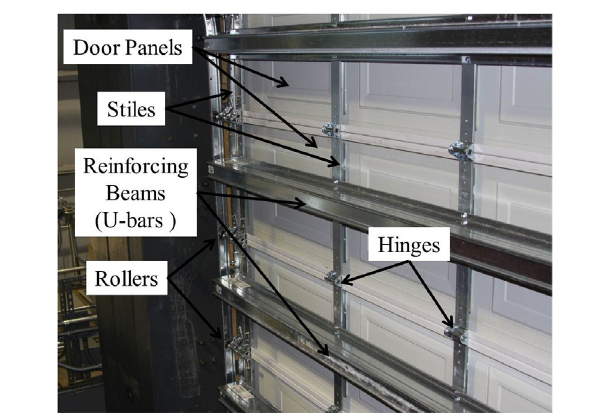
FigUre 6 | Principal components of a typical sectional door used in hurricane-prone regions